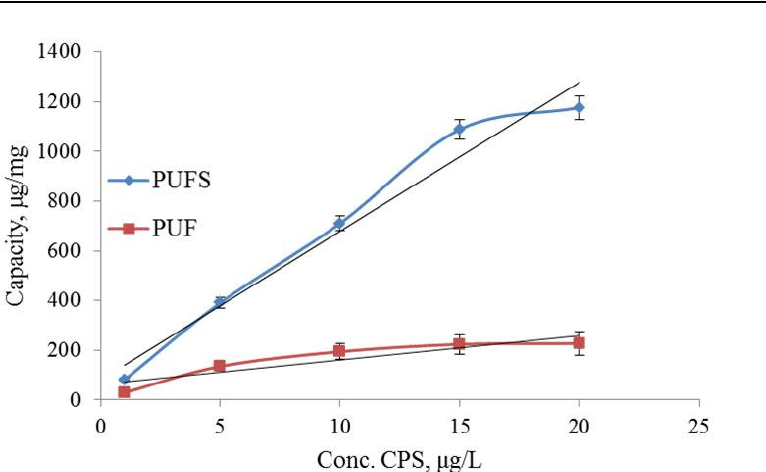
Figure 8. Effect of the initial concentration of chlorpyrifos on the sorption capacity. Experimental conditions: 25 mL volume of the solution; pH = 4, agitation speed 100 rpm, temperature 25 °C.